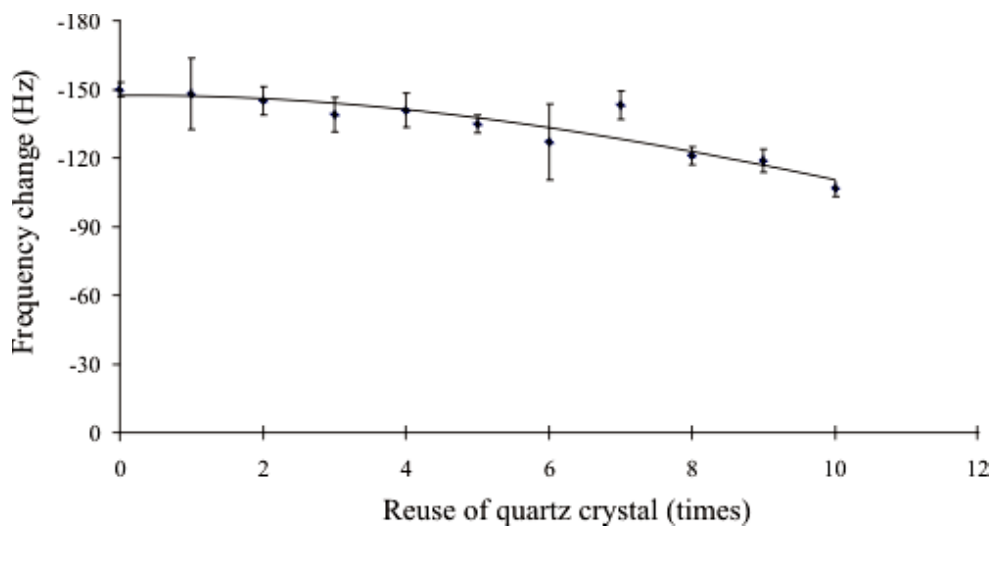
Figure 5. Resonance frequency change during testing of piezoelectric DNA-based biosensor reusability. 1.5 μ M of synthetic DNA target was applied on the sensor at room temperature for 20 minutes to hybridize with probe. Each used sensor was added with 10 μ L of 1mM HCl for one minute to wash out prior hybridized DNA target. The next cycle of hybridization was performed to test the capability of sensor. Each data point represents the mean ± SD (n =